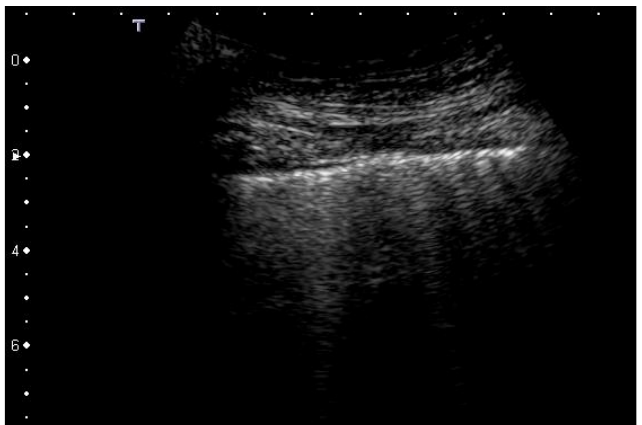
Figure 3. Vertical artifacts from a patient with scleroderma and pulmonary fibrosis. They show var- iable brightness, width, and length. Convex probe, 3 MHz. Table 1. Differences between acute cardiogenic pulmonary edema (ACPE) and ARDS (pneumo- genic) sonographic interstitial syndrome (SIS).